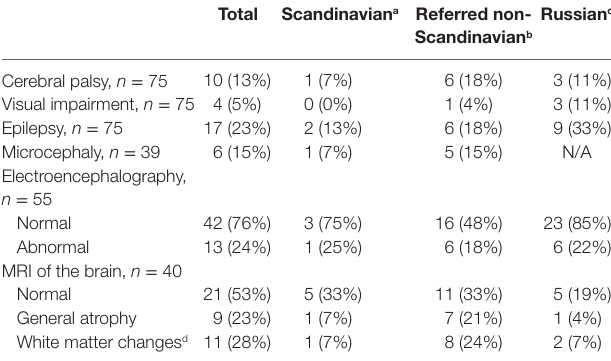
TaBle 3 | Clinical neurological outcome for children with congenital hyperinsulinism.